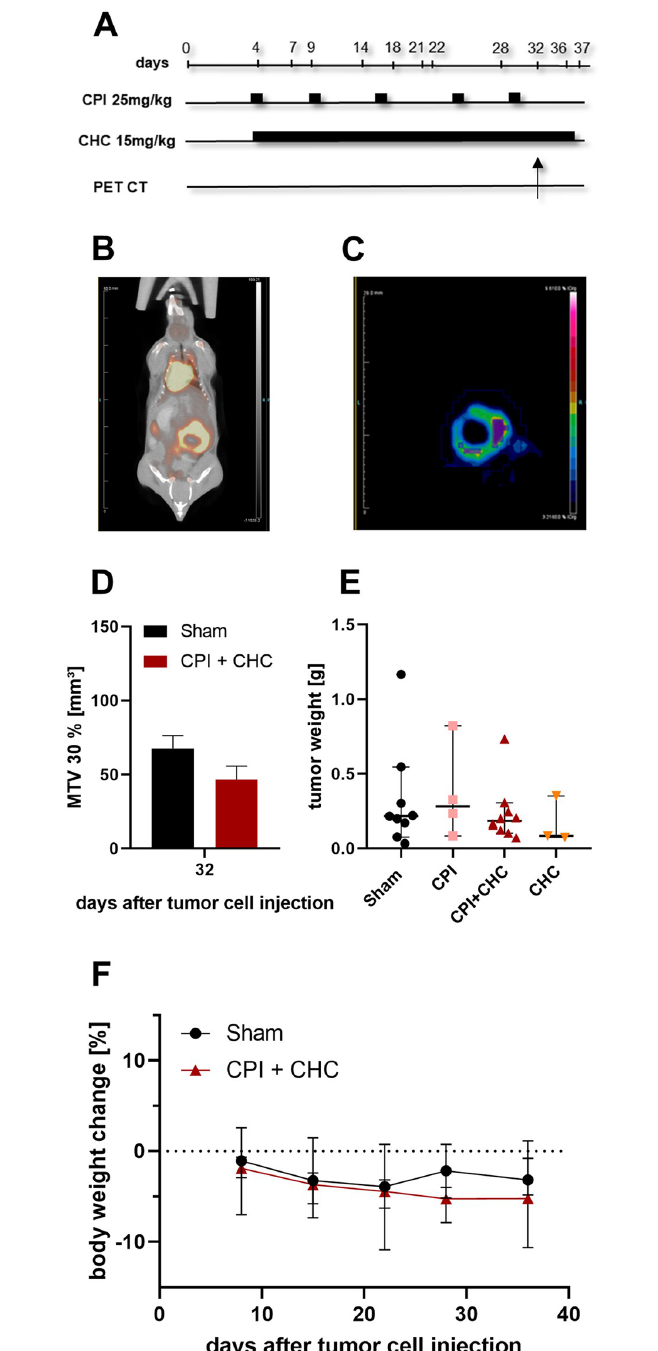
Fig 3. The combination therapy of CPI-613 and CHC (solvent: DMSO) did not lead to a significant reduction of tumor growth in vivo . ( A ) To evaluate the efficacy of the combinatorial therapy in the orthotopic pancreatic cancer model CPI-613 (25 mg/kg) was injected once a week and CHC (15 mg/kg) was applied on a daily basis from day 4 until the end of the experiment day 37. Both therapeutics were dissolved in DMSO (CPI: 100% DMSO, CHC: 50% DMSO/ 50% PBS), the sham animals were treated with the respective vehicle of the combinatorial treatment. ( B-C ) PET-CT imaging with the tracer 18 F-FDG was performed to quantify changes in the glucose metabolism of tumor tissue. ( D ) The uptake of 18 F-FDG in the tumor tissue was evaluated by metabolic tumor volume (MTV, tumor volume [mm 3 ] with the criteria 30% of the hottest voxel of injected dose/g bodyweight) on day 32 after tumor cell implantation on a subset of sham and CPI + CHC tumors. ( E ) Tumor weight was measured at the end of the experiment in the indicated